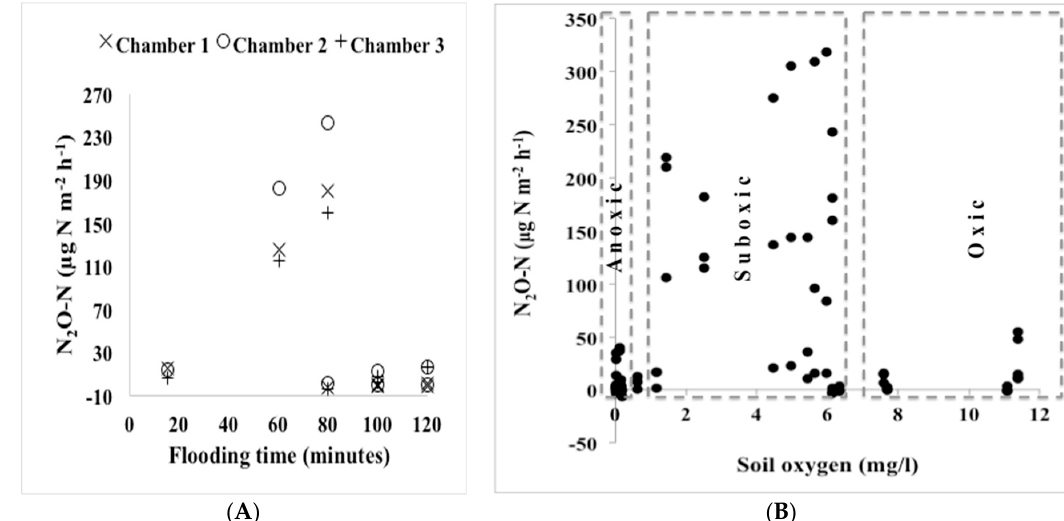
Figure 4. ( A ) N 2 O emissions varying with flooding time from three chambers per session at Position C (see Figure 1). ( B ) Variation of N 2 O emissions with varying oxygen content showing anoxic, suboxic, and oxic